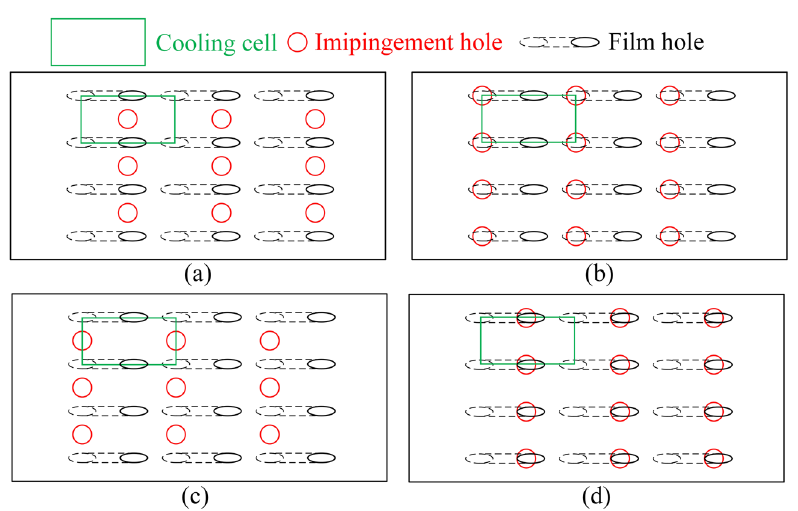
Figure 5. Layouts of impingement hole ( a ): staggered, ( b ): overlapped, ( c ): span parallel, ( d ): streamwise